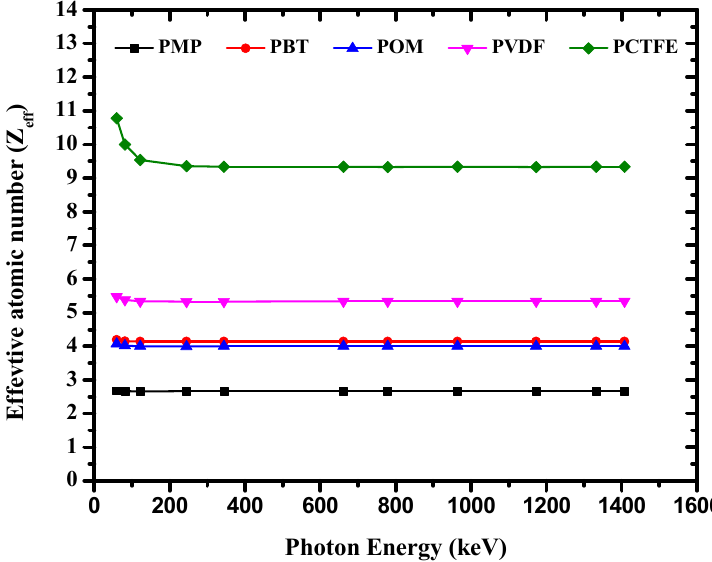
Figure 7. The variation of Z eff with photon energy for the investigated